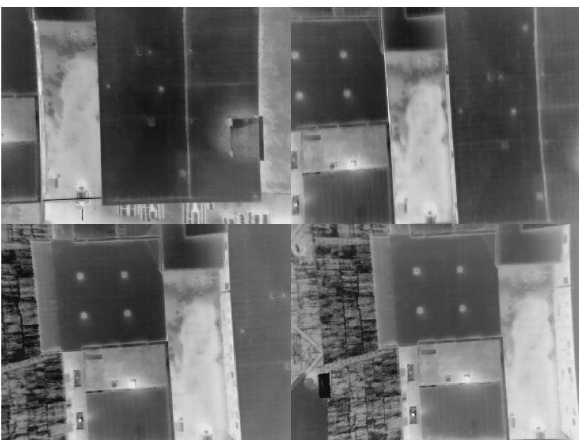
Figure 2: Four thermal images collected by FLIR Quark thermal imaging camera onboard an Aeryon Labs